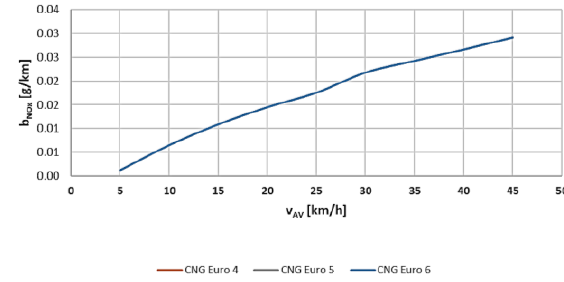
Fig. 14. NO x emission from CNG PCs for Euro standards depending on average speed